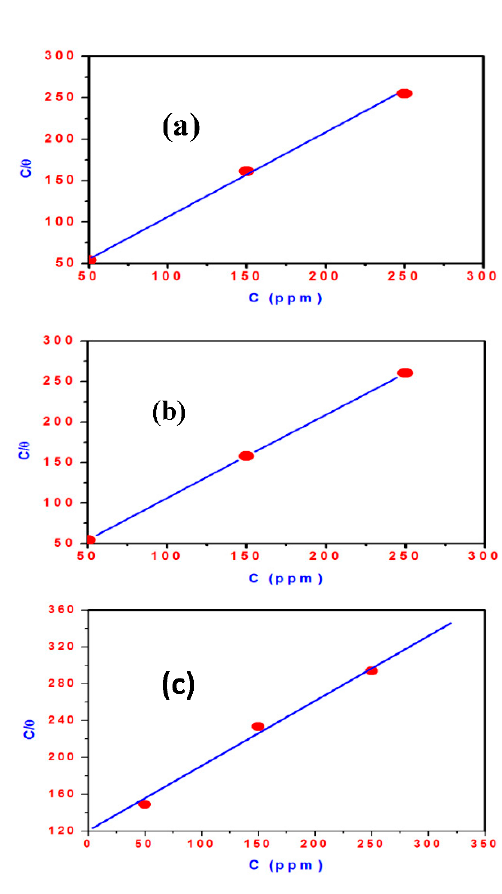
Figure 9. Langmuir adsorption plot of steel in acidic chloride solution containing different concentrations of ( a ) T3Q ( b ) T3AMPy ( c ) T3EA.